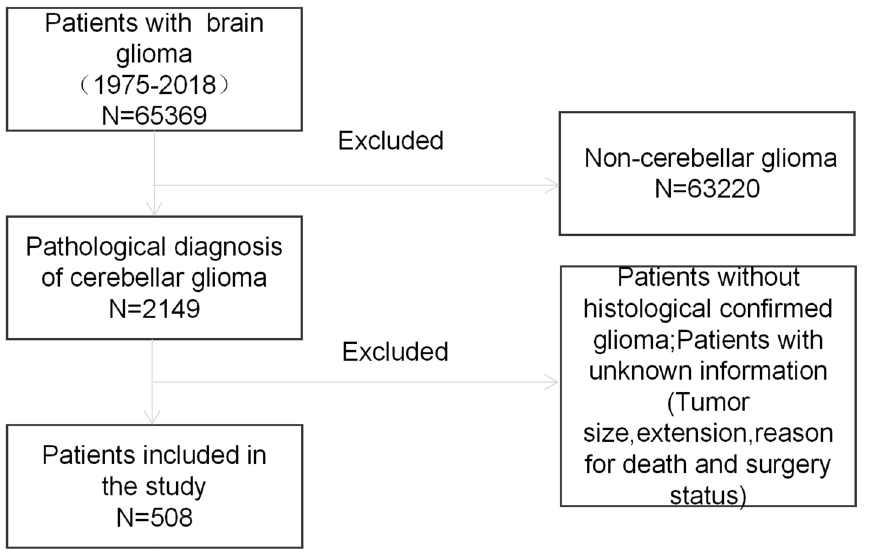
Figure 1. Flowchart of cerebellum glioma patient